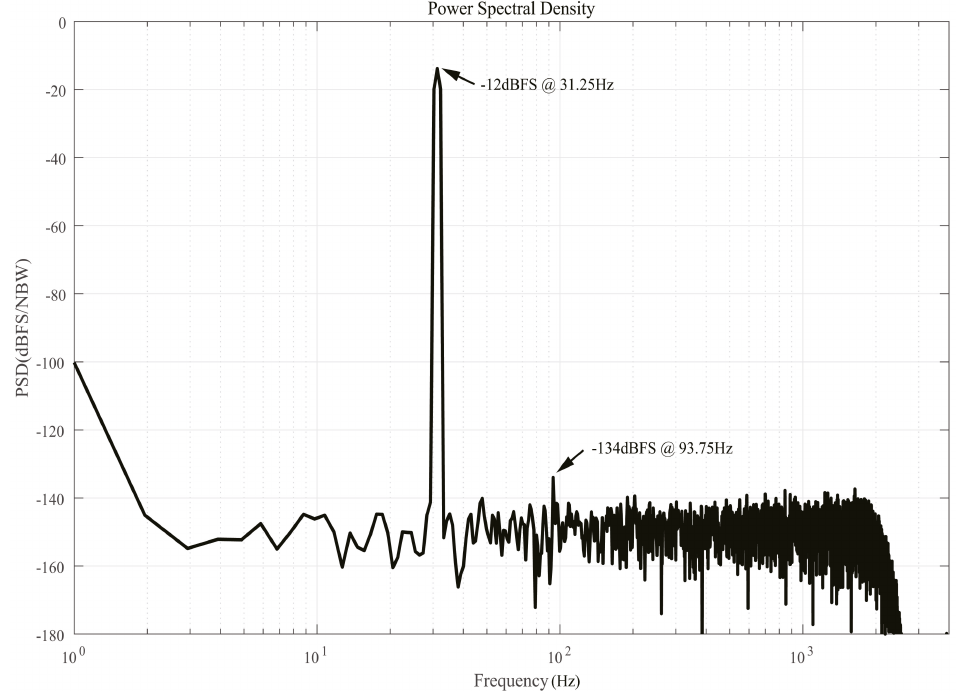
Figure 17. Measured ADC output